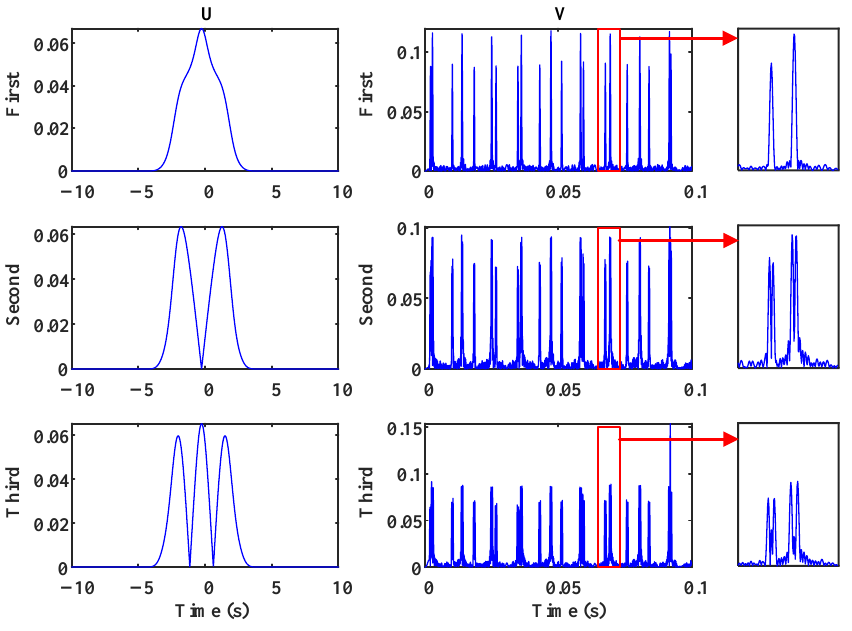
Figure 8. The first three singular vectors of the spectral matrix SVD. In order to obtain the temporal position of the flicker directly from the right singular vector, a thresholded peak detection method is proposed. First, a Gaussian smoothing process is performed on the first right singular vector to prevent the influence of individual Burr points to the extraction results. The length of the Gaussian smoothing window should not be too large to ensure that the influence on the elements in the original vector is first right singular vector. Assuming that the numerical sequence of singular vectors